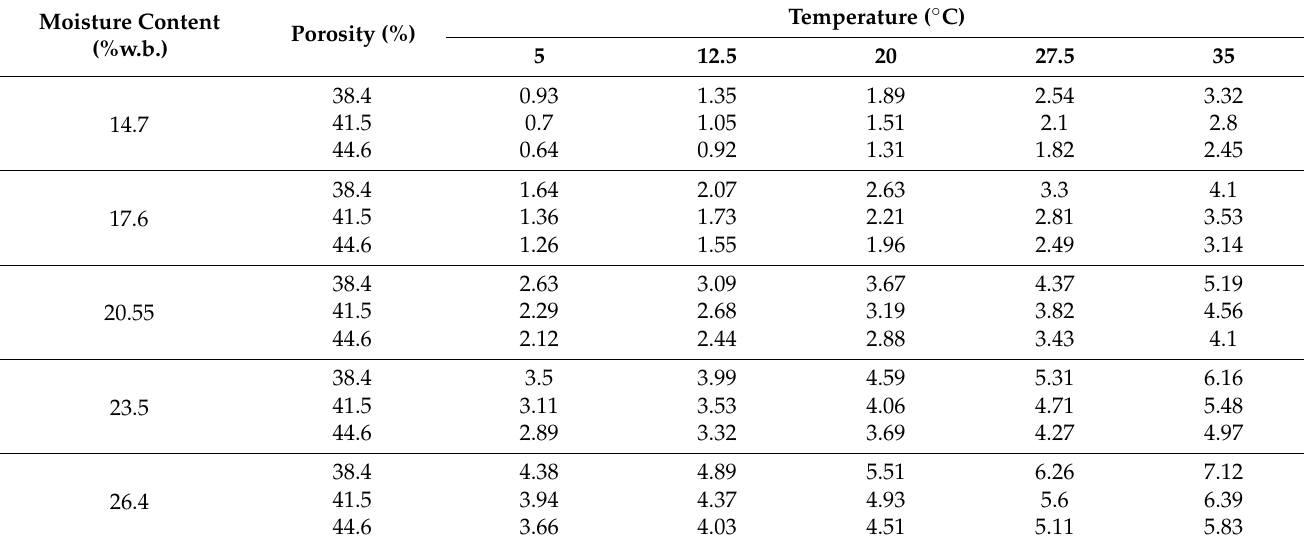
Table 3. Obtained capacitance of corn samples in different moisture contents, temperatures, and porosities. Moisture Content Porosity (%) (%w.b.)